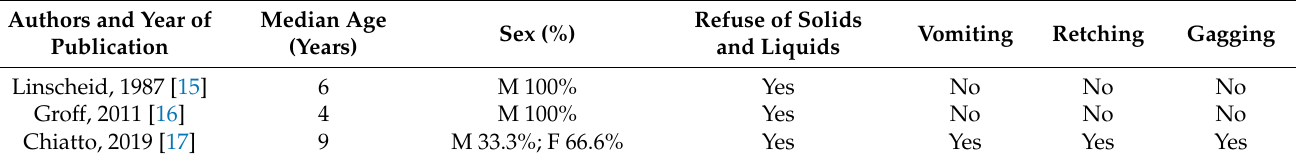
Table 2. Main characteristics of the enrolled patients and related